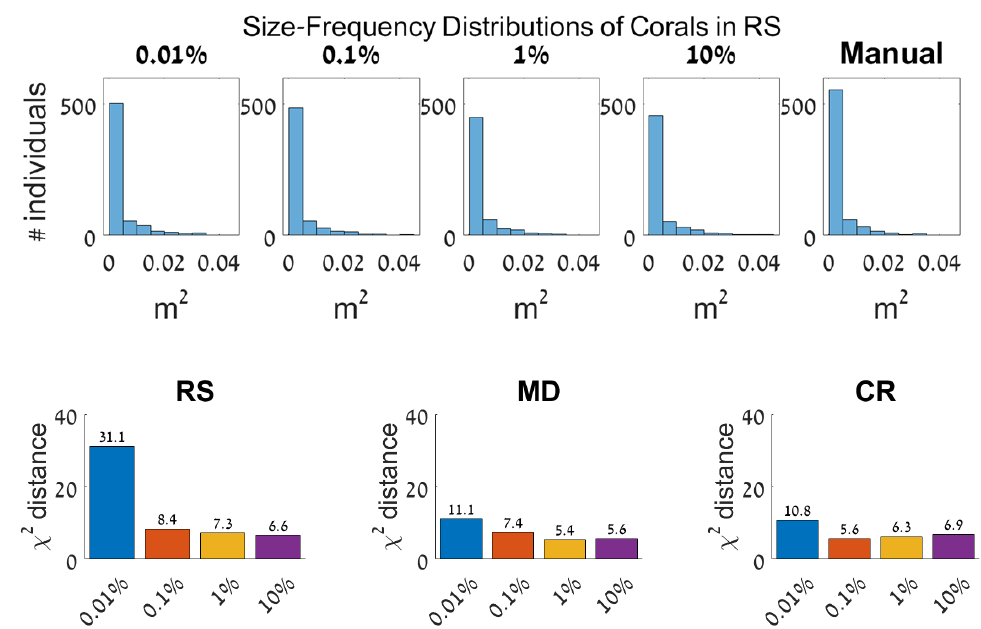
Figure 8. ( Top ) Histograms of the Coral class in the RS data-set. The histogram is divided into nine bins. ( Bottom ) Average of χ 2 distance between the size-freq. distribution of eight classes. Each photomosaic was compared to its ground-truth: Fully manually labeled photomosaic. The distance values are low and there is no significant decrease in the distance from sparsity 0.1%. In data-set CR, the trend is even slightly reversed.